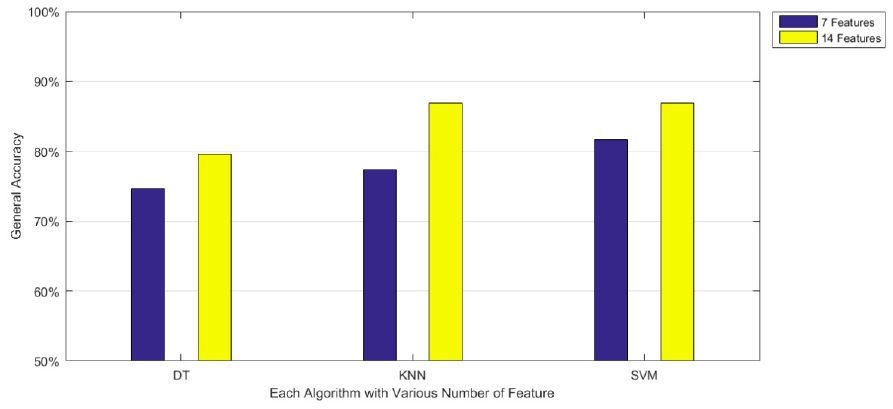
Figure 9. Comparison between two different feature sets on accuracy of three machine learning algorithms. Table 4. Confusion matrix of decision tree with the proposed features.